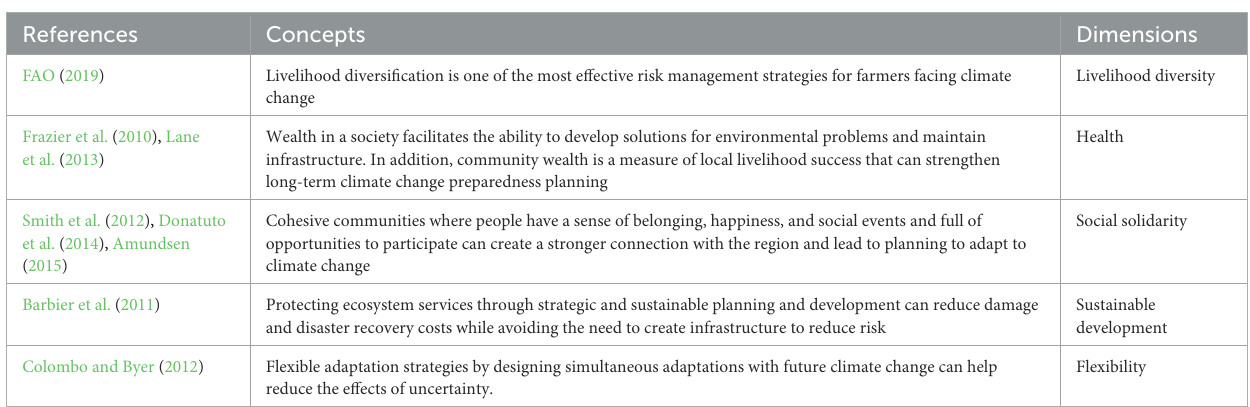
TABLE 3 Conceptualization of RCCR model